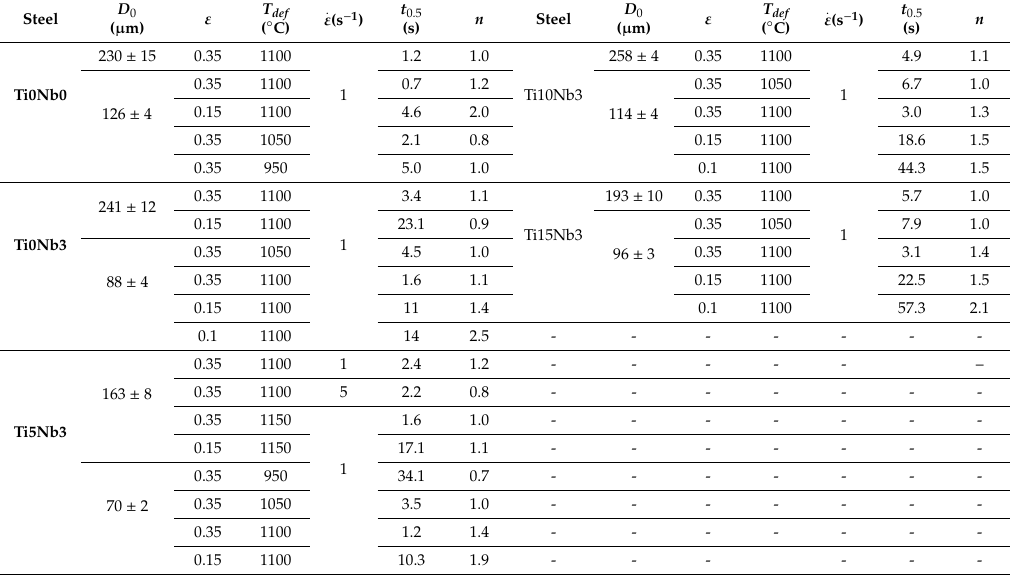
Table 5. Experimental t 0.5 and n values determined from the softening